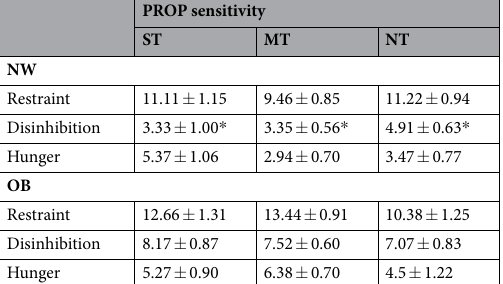
Table 2. Scores for dietary restraint, disinhibition, and perceived hunger of supertasters (ST), medium tasters (MT) and non-tasters (NT) for both participants with normal weight (NW) or with obesity (OB). The scores (mean ± SEMs) are determined by the Three-Factor Eating Questionnaire 33 . N = 110. * A significant difference between participants with normal weight or with obesity ( P < 0.049; Newman-Keuls test subsequent to the two- way